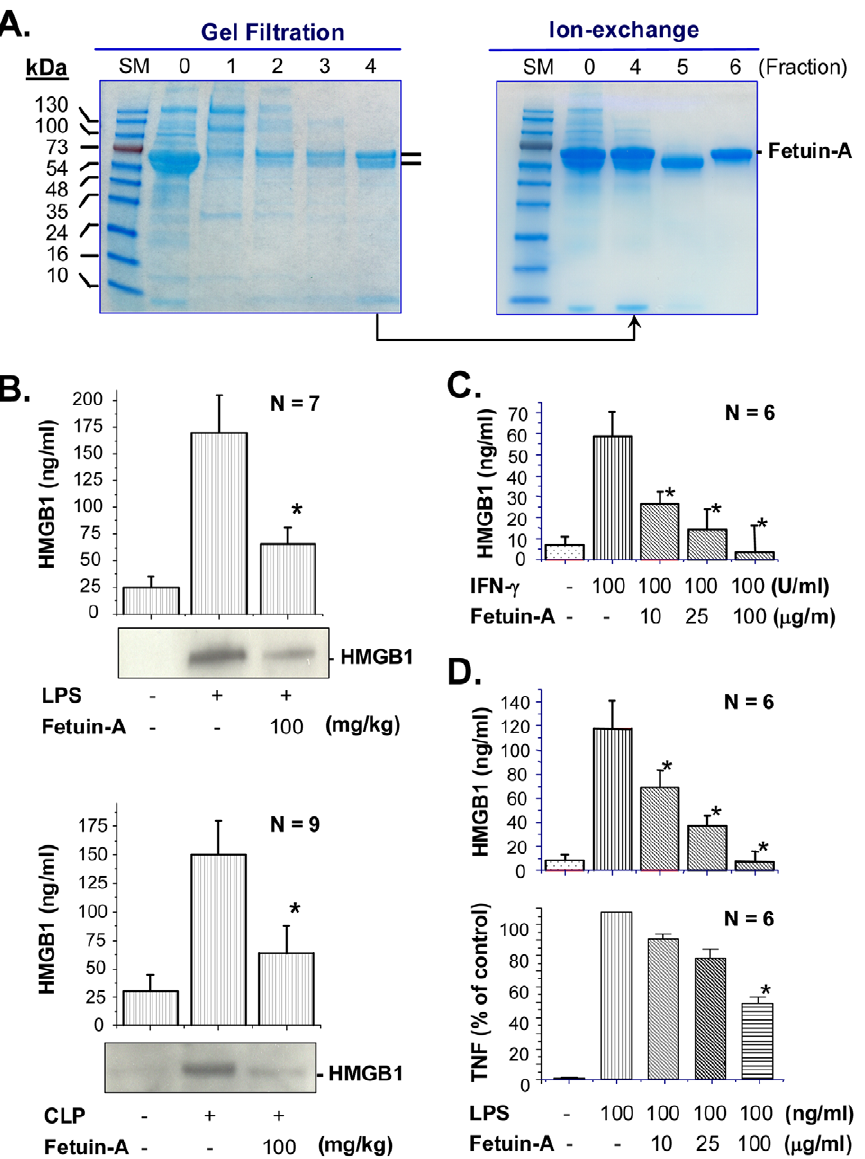
Figure 4. Highly purified fetuin-A inhibited HMGB1 release invivo and invitro . A ). Purification of fetuin-A by gel filtration and ion-exchange chromatography. Bovine fetuin-A was obtained from Calbiochem, and further purified by gel filtration and ion-exchange chromatography. Lane ‘‘0’’: crude fetuin-A from Calbiochem (Cat. # 341506), Lane 1–4: consecutive gel filtration fractions. Gel filtration fraction # 4 was further purified by ion- exchange chromatography. Lane 5–6: two major ion-exchange fractions containing a lower (Lane 5) and higher (Lane 6, ‘‘intact’’) molecular weight protein. B ). Administration of fetuin-A decreased circulating HMGB1 levels in endotoxemia and sepsis. Balb/C mice were subjected to lethal endotoxemia or sepsis, and treated with fetuin-A at + 0.5, + 24, and + 48 h post endotoxemia, or + 24 and + 48 h post CLP. Blood were collected from normal, endotoxemic (52 h post LPS), or septic (52 h post CLP) mice, respectively. Serum HMGB1 levels were determined by Western blot analysis, and expressed as mean 6 SD of two independent experiments in triplicates (N=6). *, P , 0.05 versus control ‘‘ + LPS’’ or ‘‘ + CLP’’ group. C, D ). Highly purified intact fetuin-A inhibited IFN- c - or LPS-induced HMGB1 release in primary peritoneal macrophages . Peritoneal macrophages were isolated form Balb/C mice, and stimulated with IFN- c or LPS at indicated concentrations in the absence or presence of highly purified intact fetuin-A for 16 h. The culture medium was assayed for HMGB1 levels by Western blotting analysis ( Panel C, D ) and TNF- a levels by ELISA ( Panel D ), and expressed as Mean 6 S.D. of two independent experiments in triplicates (N=6). *, P , 0.05 vs ‘‘ + IFN- c ’’ ( Panel C ) or ‘‘ + LPS’’ ( Panel D ).